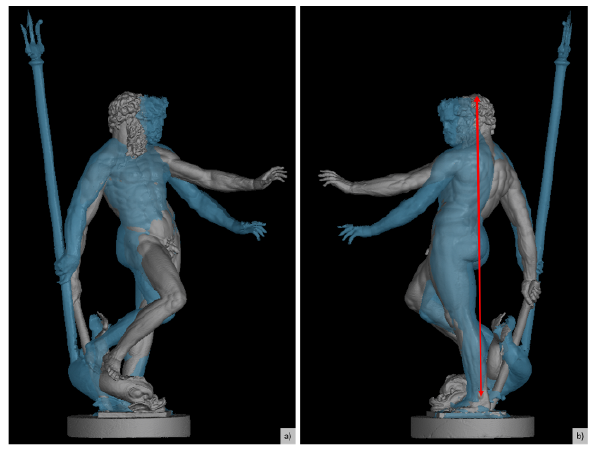
Figure 10. Two views of the comparison between the statues, after scaling of the archetype using the height, evidenced in red (the light-blue model is the big Neptune, the grey model is the archetype).